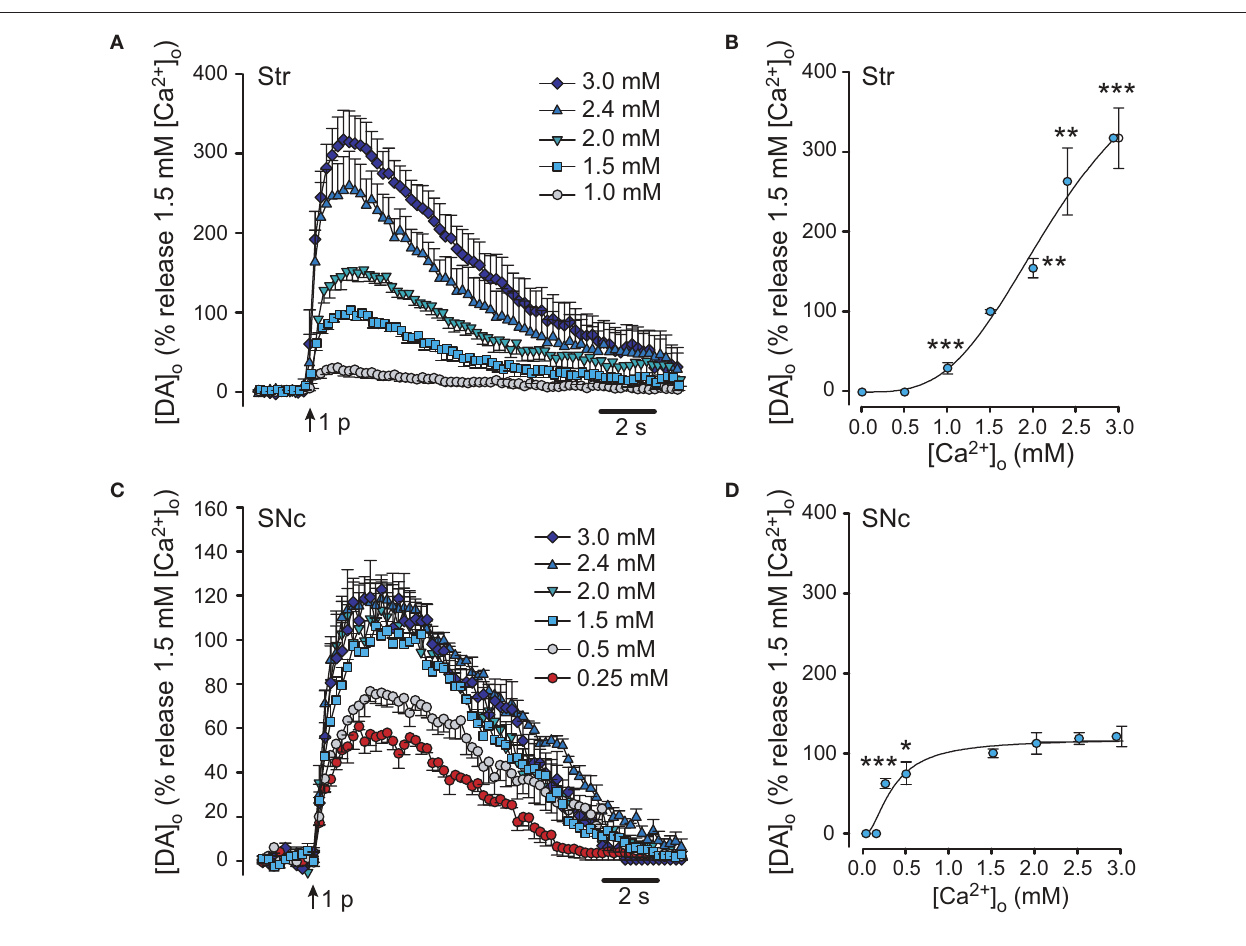
Figure 1 | Ca 2 + dependence of evoked synaptic DA release in dorsal striatum and SNc. ( A ) Average single-pulse evoked [DA] in dorsal striatum in o varying [Ca 2 + ] . Maximum [DA] in 1.5 mM [Ca 2 + ] in dorsal striatum was taken o o o as 100%. Release could not be evoked in [Ca 2 + ] ≤ 0.5 mM, but o